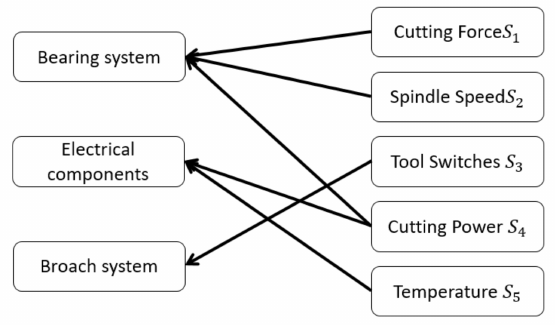
Figure 4. Mapping of stress and spindle subsystem.